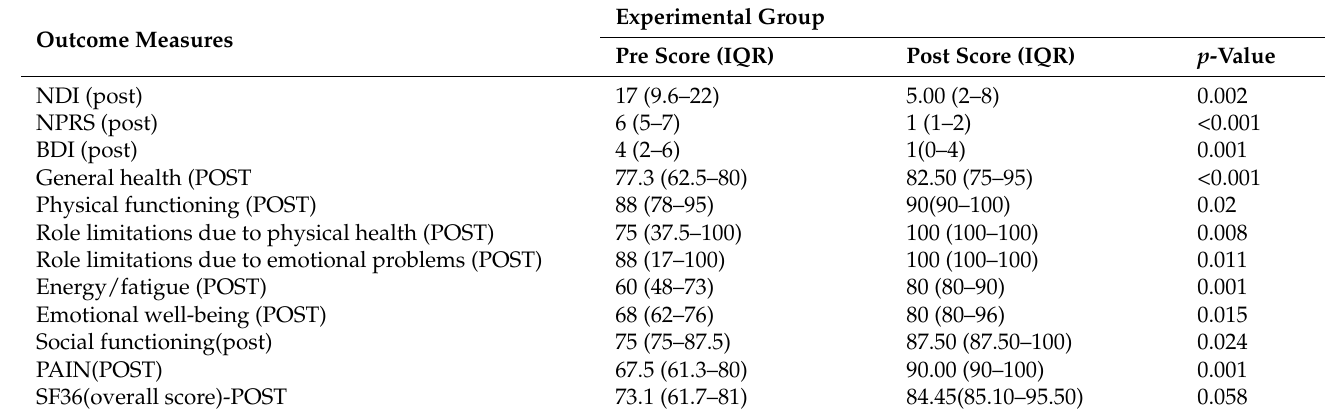
Table 5. Within-group comparison of the experimental group.